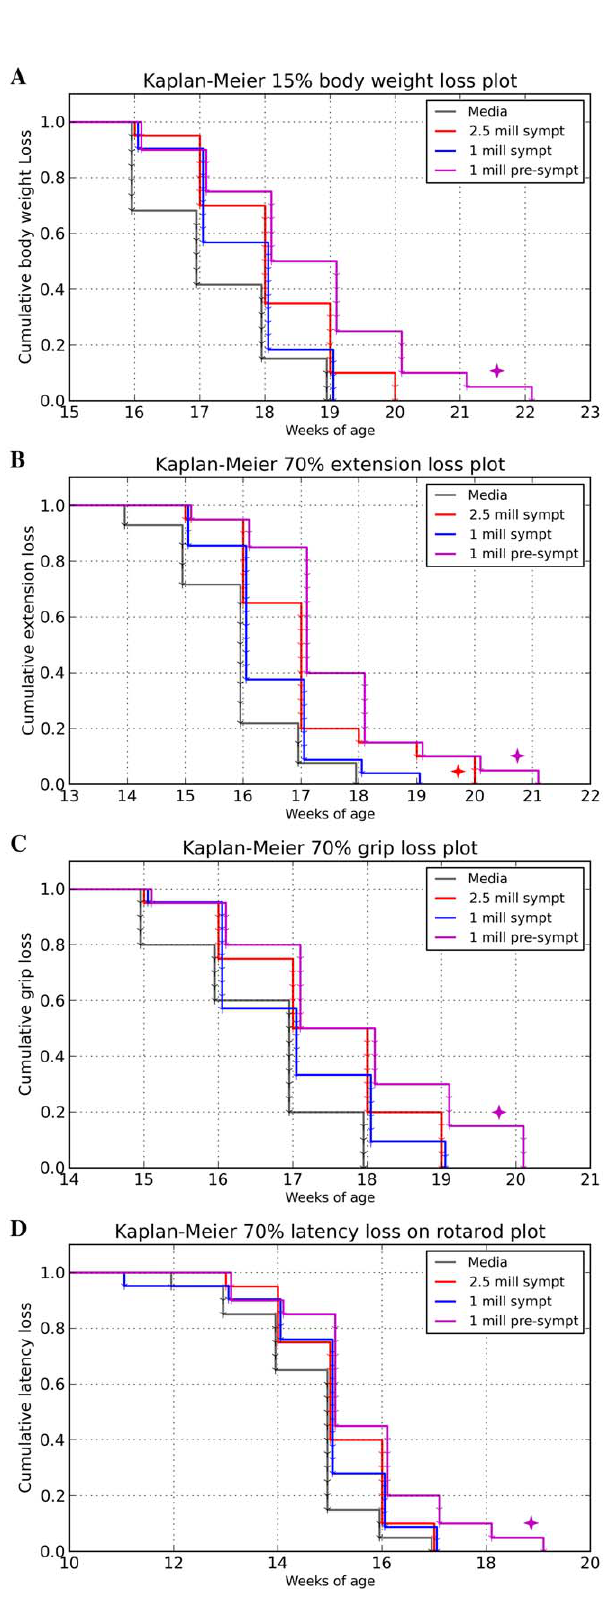
Figure 2. Evaluations of disease progression in G93A mice through Kaplan-Meier analysis. ( A ) Time elapsed until animals lost 15% of their maximum body weight. Mice receiving 1 6 10 6 cells pre- symptomatically ( Gr 3 ) significantly